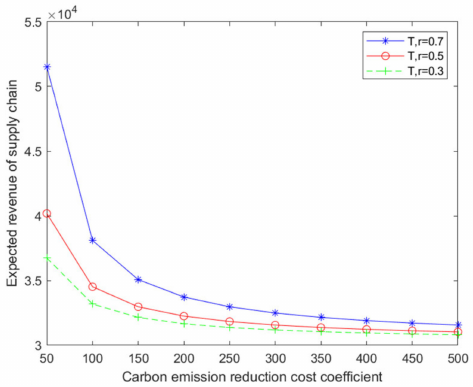
Figure 8. In the condition of centralized decision making with government carbon emission reduction subsidies, the impact of the carbon emission reduction coefficient on the expected return of the supply chain under different government subsidy rates is